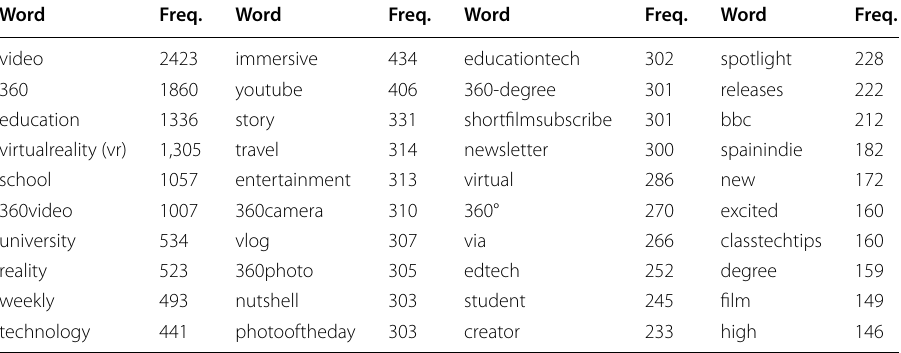
Table 8 Frequency of the top-40 most commonly used words within the tweets including keywords in the years of 2010–2020 Word